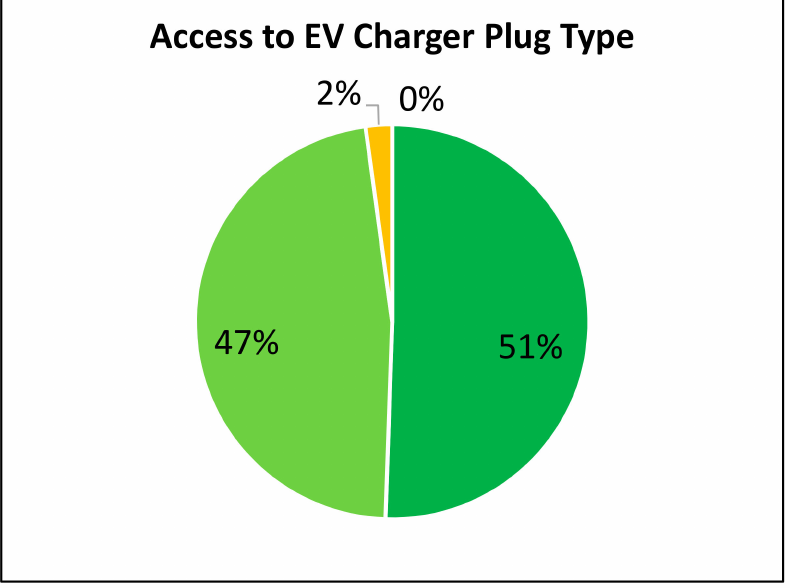
Figure 24. User satisfaction toward availability of charger